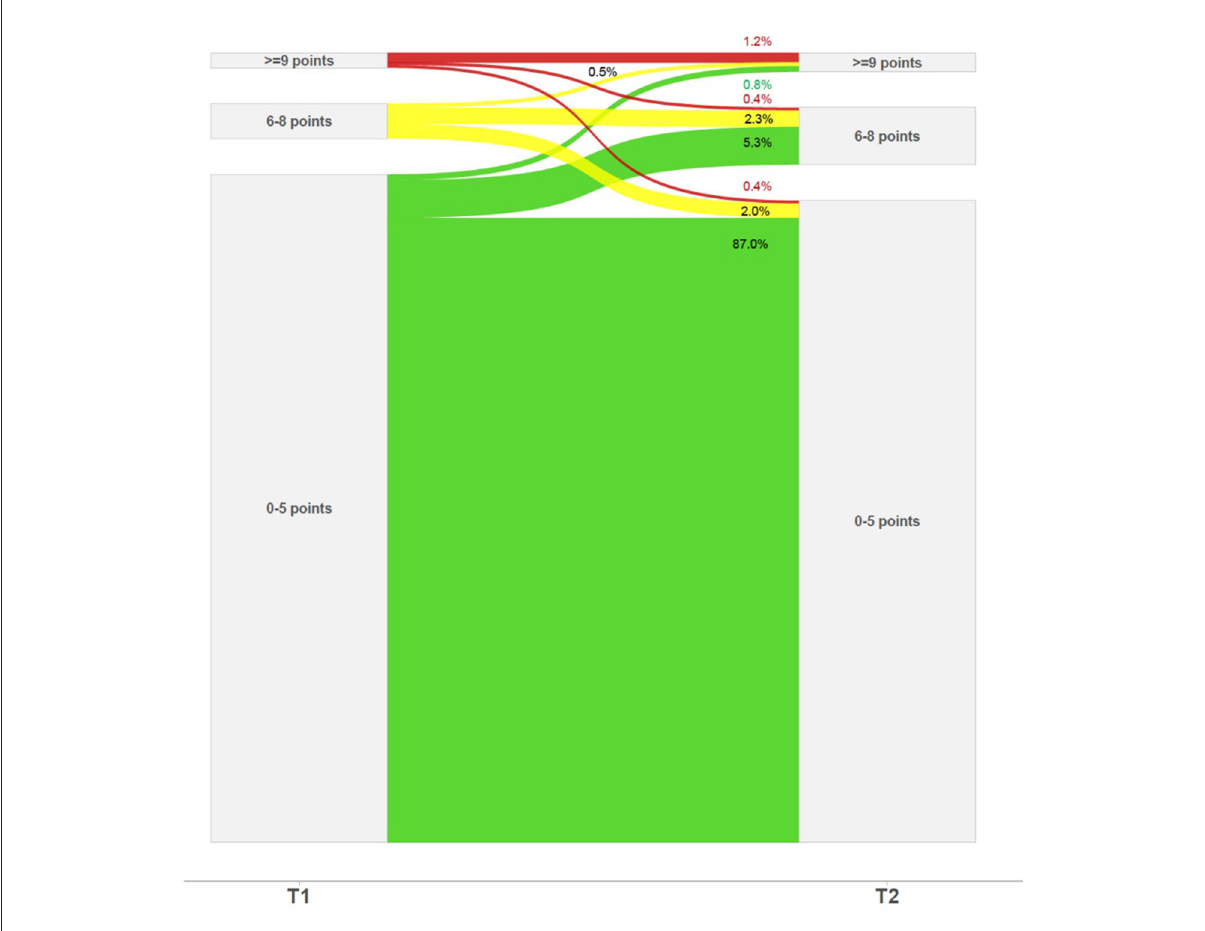
FIGURE2 PHQ-4 mental health trajectories between T1 and